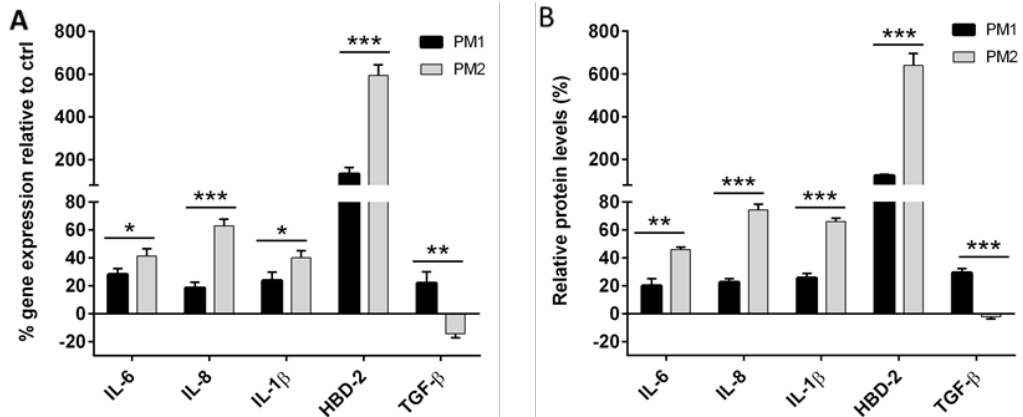
Figure 6. Relative gene expression ( A ) and protein concentration ( B ) in T24 cells infected with PM1 or PM2. Data are mean ± SD and are expressed as percentage of increment relative to unstimulated T24 cells (ctrl). Significant differences are indicated by * p < 0.05, ** p < 0.01, *** p < 0.001 for comparison of PM1 vs. PM2.